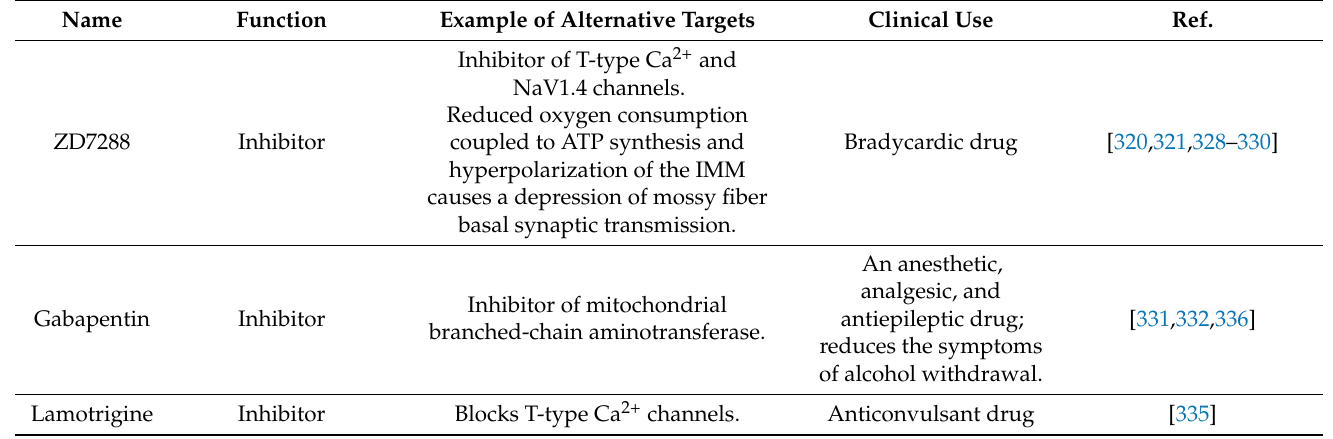
Table 6. Examples of modulators of mitoHCN channels and their off-target